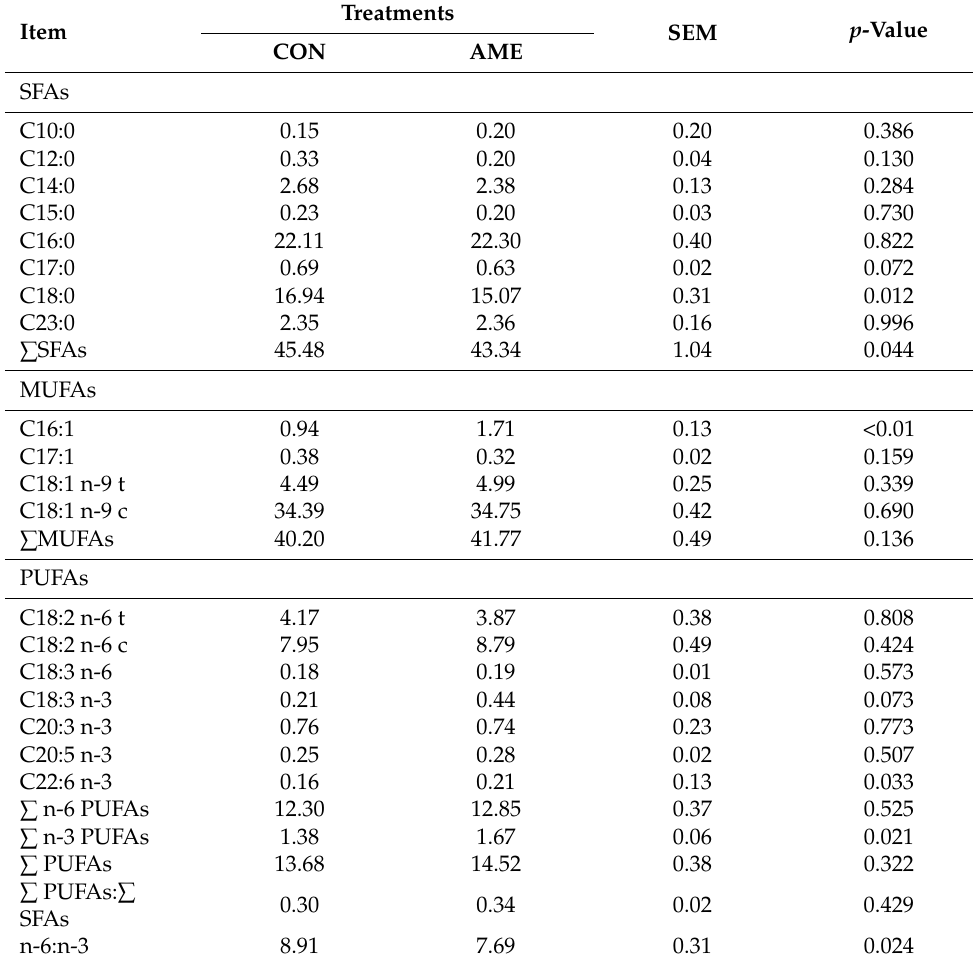
Table 6. Effect of AME on fatty acid composition in LD muscle of lambs